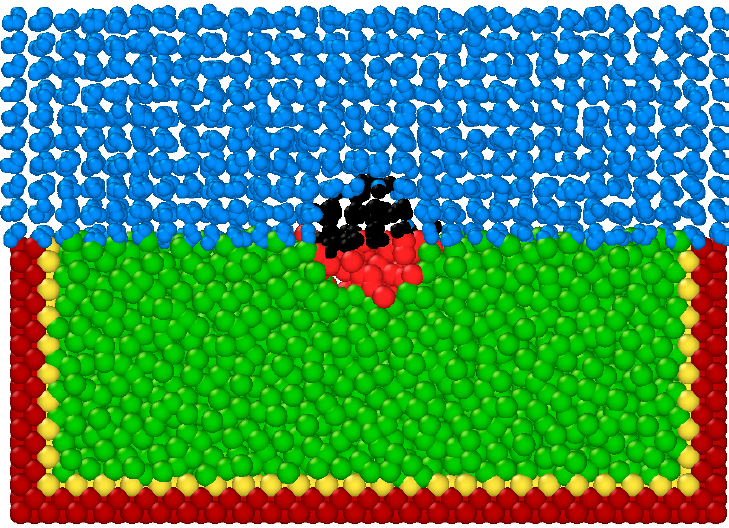
Figure 8. MD Simulation Snapshot of Cavity Machined during LA-LBMM Process (Static Mode).